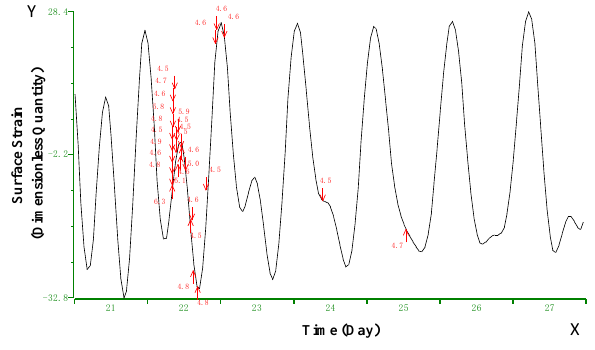
Fig. 3. The occurrence time distribution of earthquakes in the af- tershock sequence of the M L = 6.3, February 2011 New Zealand earthquake superimposed on the theoretical curve of the solid earth tide (UTC+8). The X-axis is time (day) from 21 February 2011 to 27 February 2011 and Y-axis is surface strain (dimensionless quan- tity). The surface strain can normally describe the changes of solid